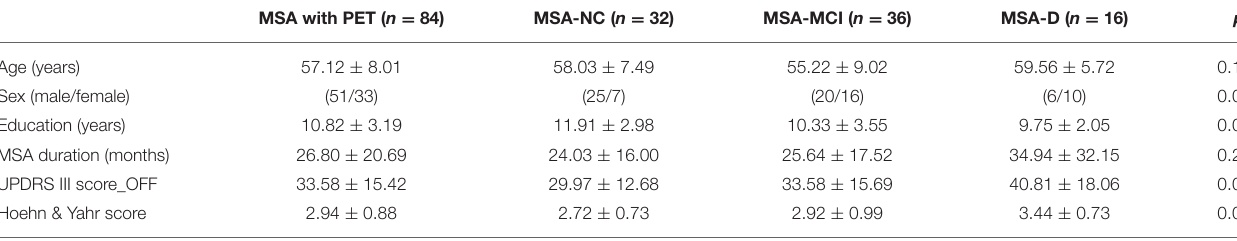
TABLE 1 | Demographic and clinical characteristics in three cognitive statuses of 84 MSA patients with PET